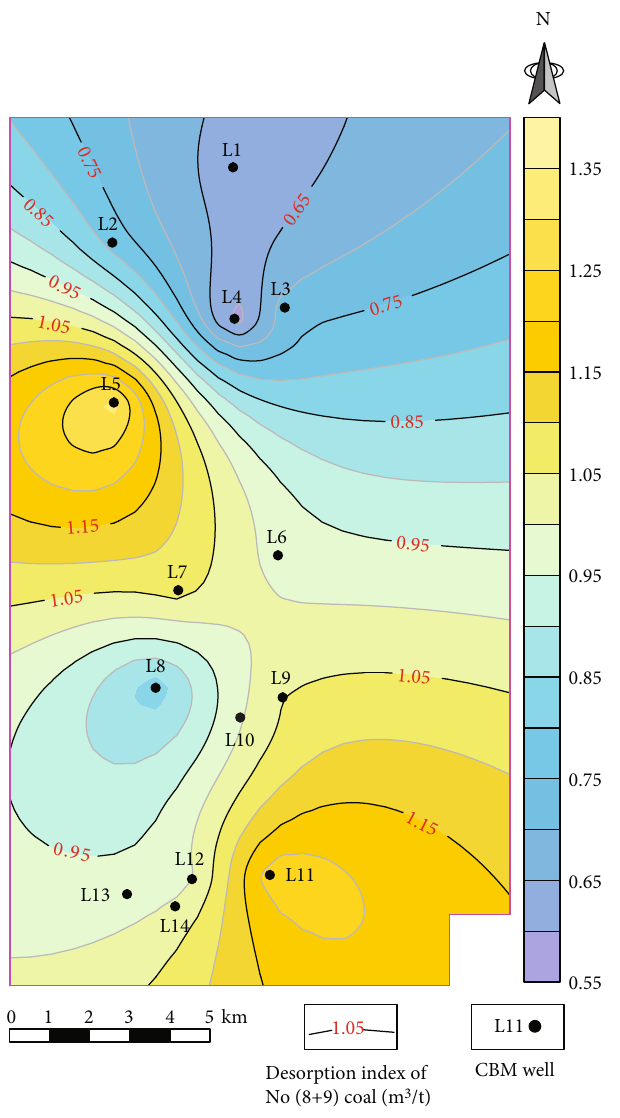
Figure 7: Contour map of desorption index of No. ( 8 + 9 ) coal in Yangjiapo block.